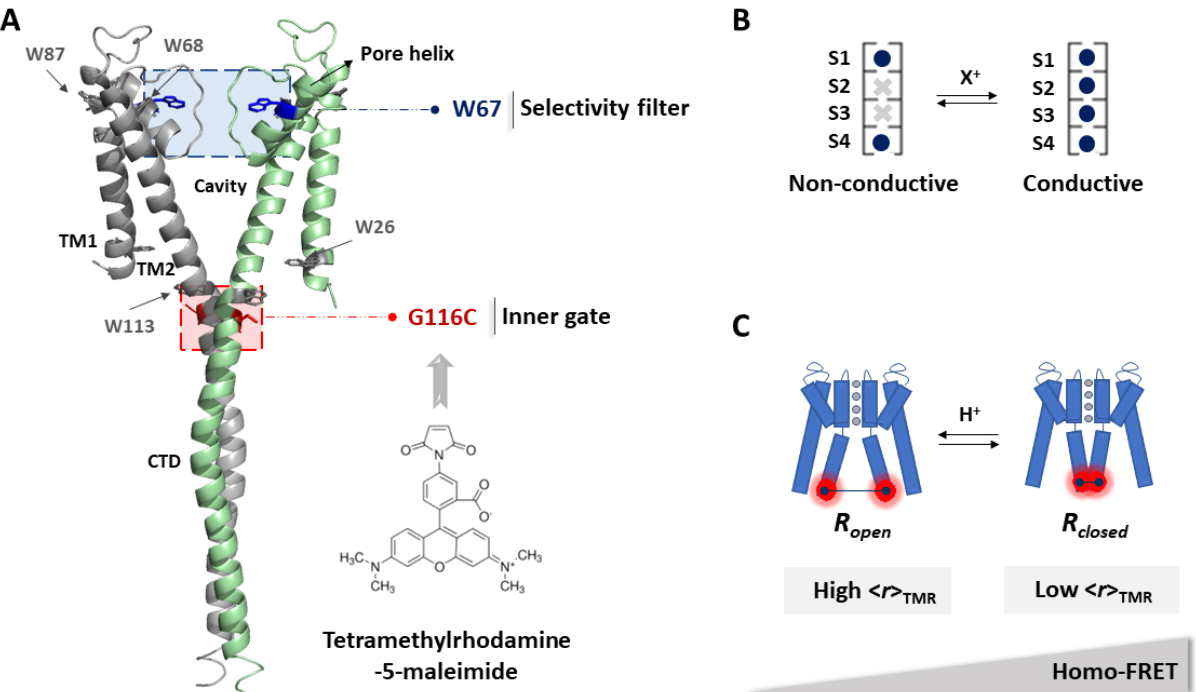
Figure 1. Schematic representation of the KcsA channel and its two gates. ( A ) Full-length structure of KcsA in the closed state (PDB: 3EFF). Two of the four monomers are depicted for clarity. Each monomer consists of two transmembrane helices (TM1 and TM2), a short, tilted pore helix, the selectivity filter (SF), and the C-terminal domain (CTD). KcsA also has five Trp residues per monomer distributed between the intracellular and extracellular mouths of the channel. In this work, W26, 68, 87, and 113 were mutated to phenylalanine, leaving W67 as the sole fluorescent reporter at the pore helix. The G116C mutation was incorporated at the opposite end of the protein to enable its specific conjugation to tetramethylrhodamine-5-maleimide (TMR-M) at this gating-sensitive position. ( B ) The conformation of the SF (outer gate) is modulated by the type and cation concentration X + in solution, adopting either a conductive or a non-conductive conformation. This conformational equilibrium can be tracked by measuring the fluorescence anisotropy of W67, < r > W67 . ( C ) The conformational shift of the inner gate of KcsA between an open and a closed conformation is modulated by the H + concentration in solution. The opening of this gate can be monitored by an increase in the TMR fluorescence anisotropy, < r > TMR , due to a decrease in the efficiency of the intramolecular homo-FRET process among the multiply conjugated dyes to a single